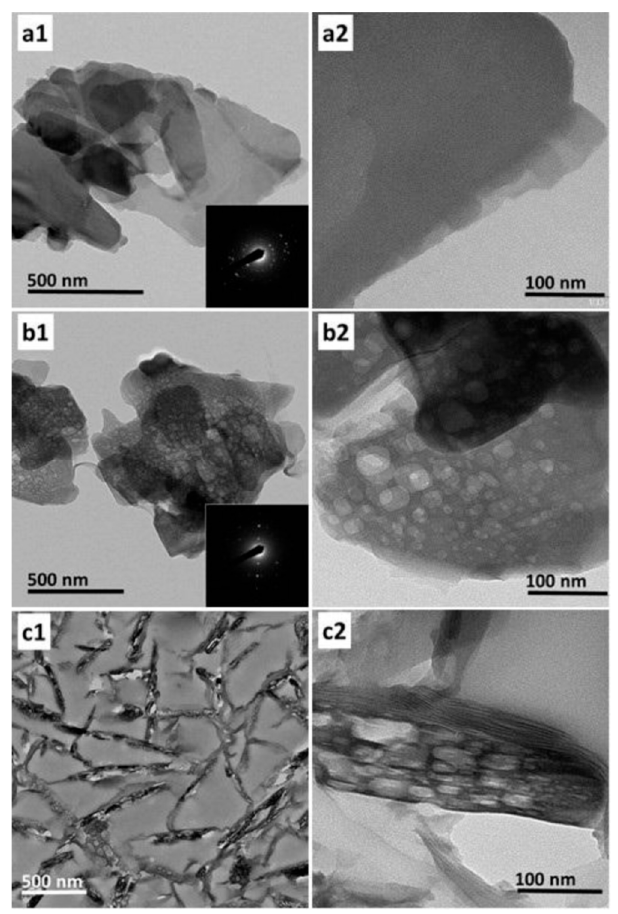
Figure 6. ( a1 – c1 ) low-magnification and ( a2 – c2 ) high-magnification TEM images of FER zeolite samples synthesized with CTAB in NaOH solution with di ff erent NaOH concentration of ( a ) 0.05, ( b ) 0.25, Figure 6. ( a1–c1 ) low-magnification and ( a2–c2 ) high-magnification TEM images of FER zeolite and ( c ) 0.5 mol / L at 130 ◦ C for 72 h, respectively. Reprinted with permission from ref. [102]. Copyright samples synthesized with CTAB in NaOH solution with different NaOH concentration of ( a ) 0.05, ( b ) 2018, 0.25, and ( c ) 0.5 mol/L at 130 °C for 72 h, respectively. Reprinted with permission from ref. [102]. Copyright 2018, Elsevier.